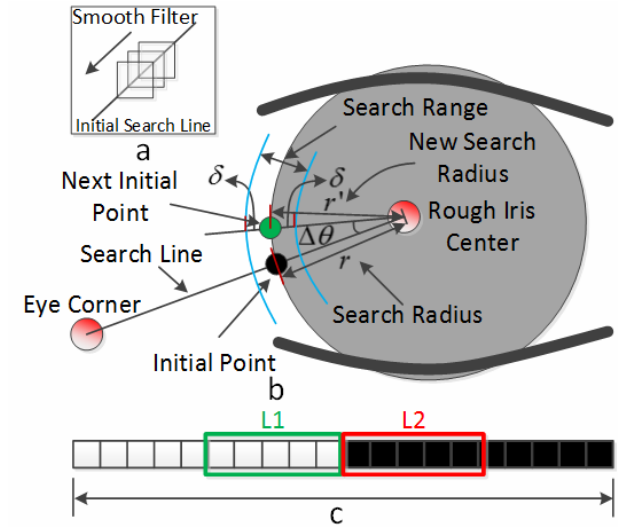
Figure 10: (a) shows a smooth filter moving along the initial search line for removing highlights on iris region. (b) shows the schematic diagram of the detection method of iris edge. (c) shows two sliding windows marked with red and green rectangles for the calculation of the line integral ratio between them to determine the initial point.